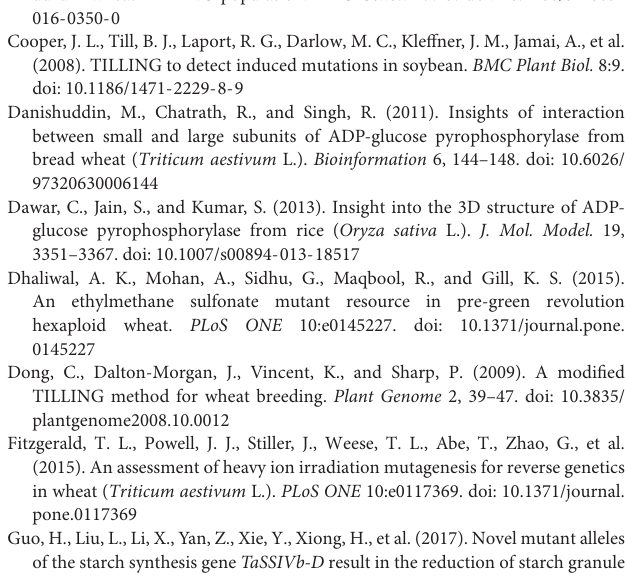
FIGURE S1 | Seeds used in EMS treatment and seedlings post-EMS treatment. (a) Dry seeds; (b) germinated seeds for EMS treatment; (c) seedlings after EMS treatment. FIGURE S2 | Diagram of the gene TaAGP.L-B1 structure. The black rectangle represents the genomic sequence of the gene; orange arrowheads and rectangles indicate exons and their locations; blue rectangles represent 2 sets of specific primers. FIGURE S3 | Alignment of the amino acid sequence of the AGPase large subunit. Black rectangles show wheat line point mutations in amino acid sites resulting from EMS-treatment. Sequences were aligned using ClustalX, Accession numbers of potato, maize, and rice are Q00081.1, P55241.1, and ACJ71342.1